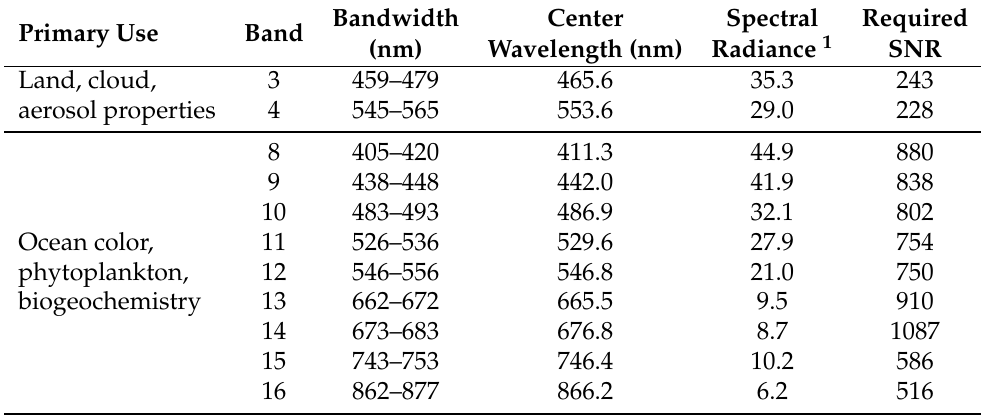
Table 1. MODIS channel